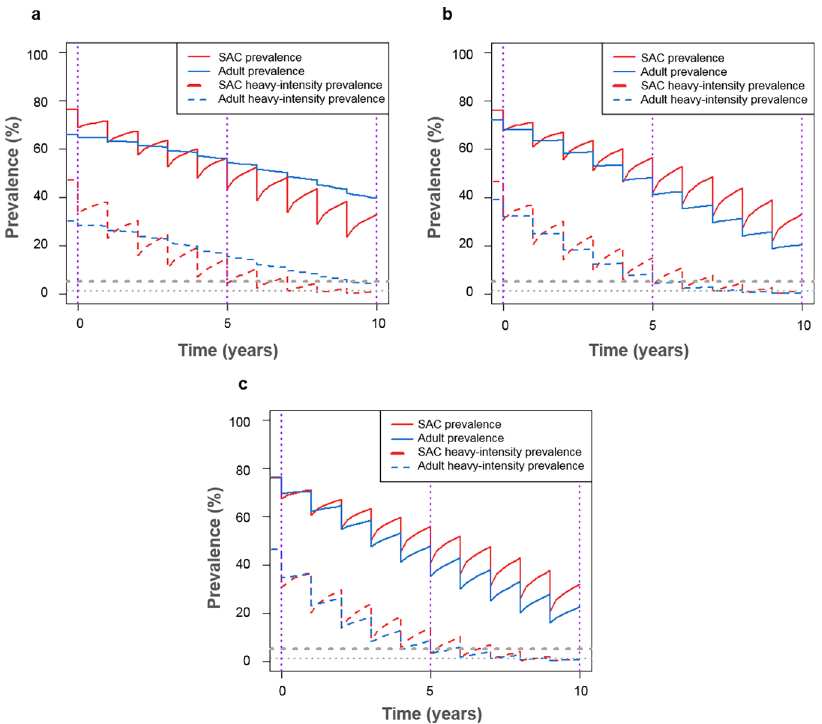
Fig 4. Model projections of annual treatment for high prevalence settings ( (cid:21) 50% SAC baseline prevalence) using coverage levels required to achieve elimination as a public health problem within 10 years. With (a) low adult burden of infection (R 0 = 3.0) treating 80% school-aged children (SAC; 5–14 years of age) and 16% adults (15+ years of age), (b) moderate adult burden of infection (R 0 = 3.5) treating 85% SAC and 52% adults, and (c) high adult burden of infection (R 0 = 4.0) treating 85% SAC and 76% adults.